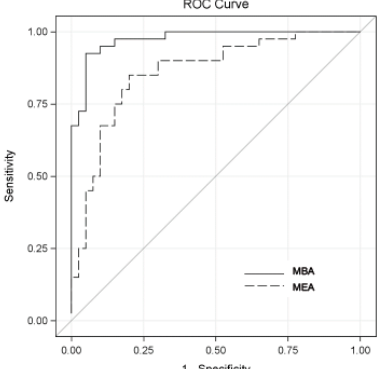
Figure 1. Diagnostic performance of bladder-cancer-associated molecular panels combining all biomarkers. A receiver operating characteristic (ROC) curves for MBA (solid line) and MEA (dashed line) assays are shown. The areas under the curves were 0.97 for MBA and 0.86 for MEA. The sensitivity and specificity values maximizing the Youden index (sensitivity ± specificity − 1) for MBA were 0.93 and 0.95, respectively, and for MEA were 0.85 and 0.80. Accuracy, positive predictive values (PPV), and negative predictive values (NPV) for MBA were 0.94, 0.95, and 0.93, respectively, and for MEA were 0.83, 0.81, and 0.84.